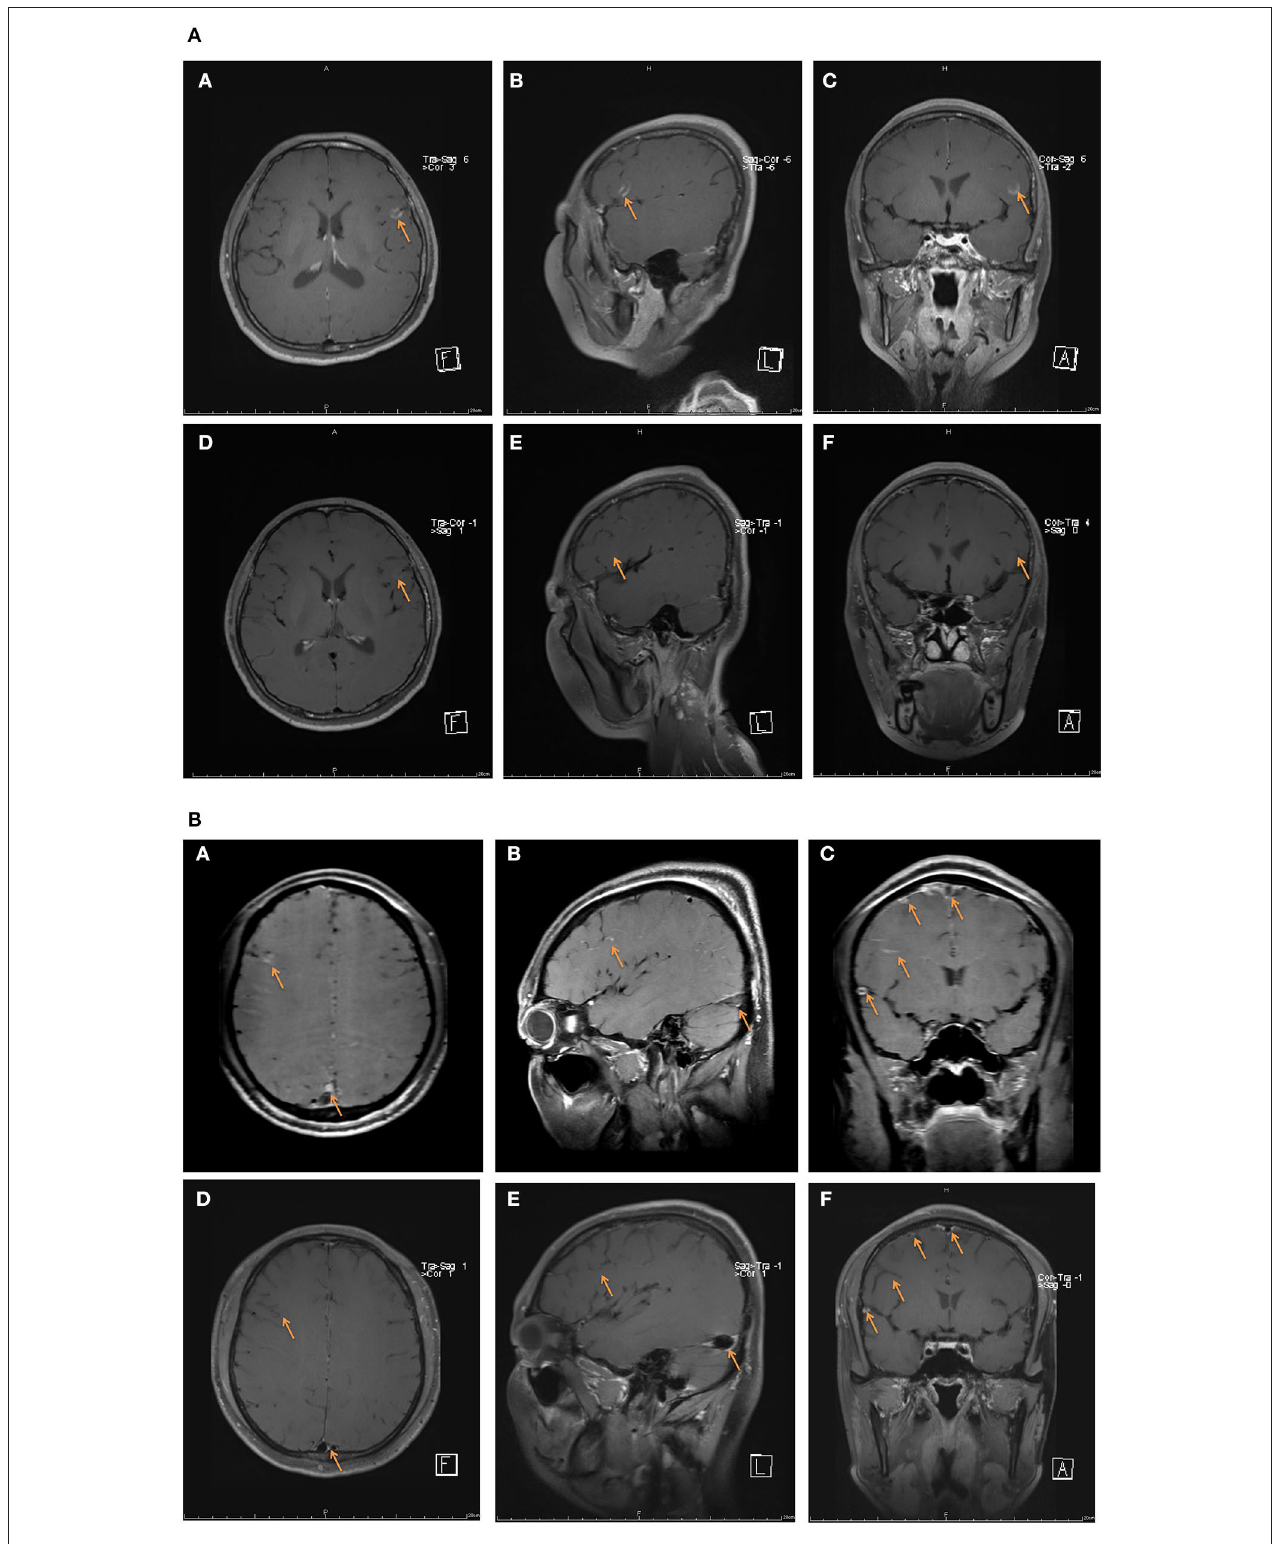
FIGURE 5 | Contrast-enhanced HR-MRBTI of the brain during the pre-batroxobin period (upon admission) and post-batroxobin period (2-week follow-up). (A) Case 19: a thirty-seven-year-old female with thrombosis in multiple sites of the left frontal lobe was given batroxobin as well as anticoagulation therapy. (A–C) pre-batroxobin period (upon admission), (D–F) post-batroxobin period (2-week follow-up). (B) Case 18: a thirty-one-year-old male with CVST in multiple sinuses and thrombosis in multiple sites of right frontotemporal lobes was administrated batroxobin after a two-time thrombectomy of CVST. (A–C) pre-batroxobin period (upon admission), (D–F) post-batroxobin period (2-week follow-up). Frontiers in Neurology |